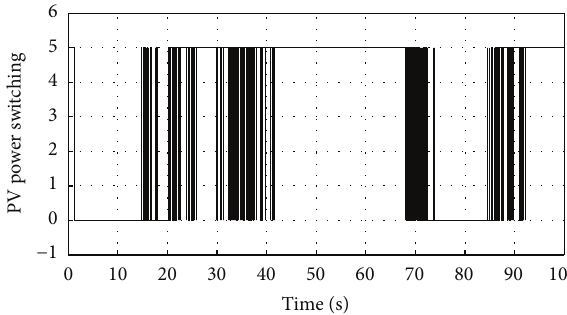
Figure 25: Switching instants of PV system when wind energy is not sufficient.